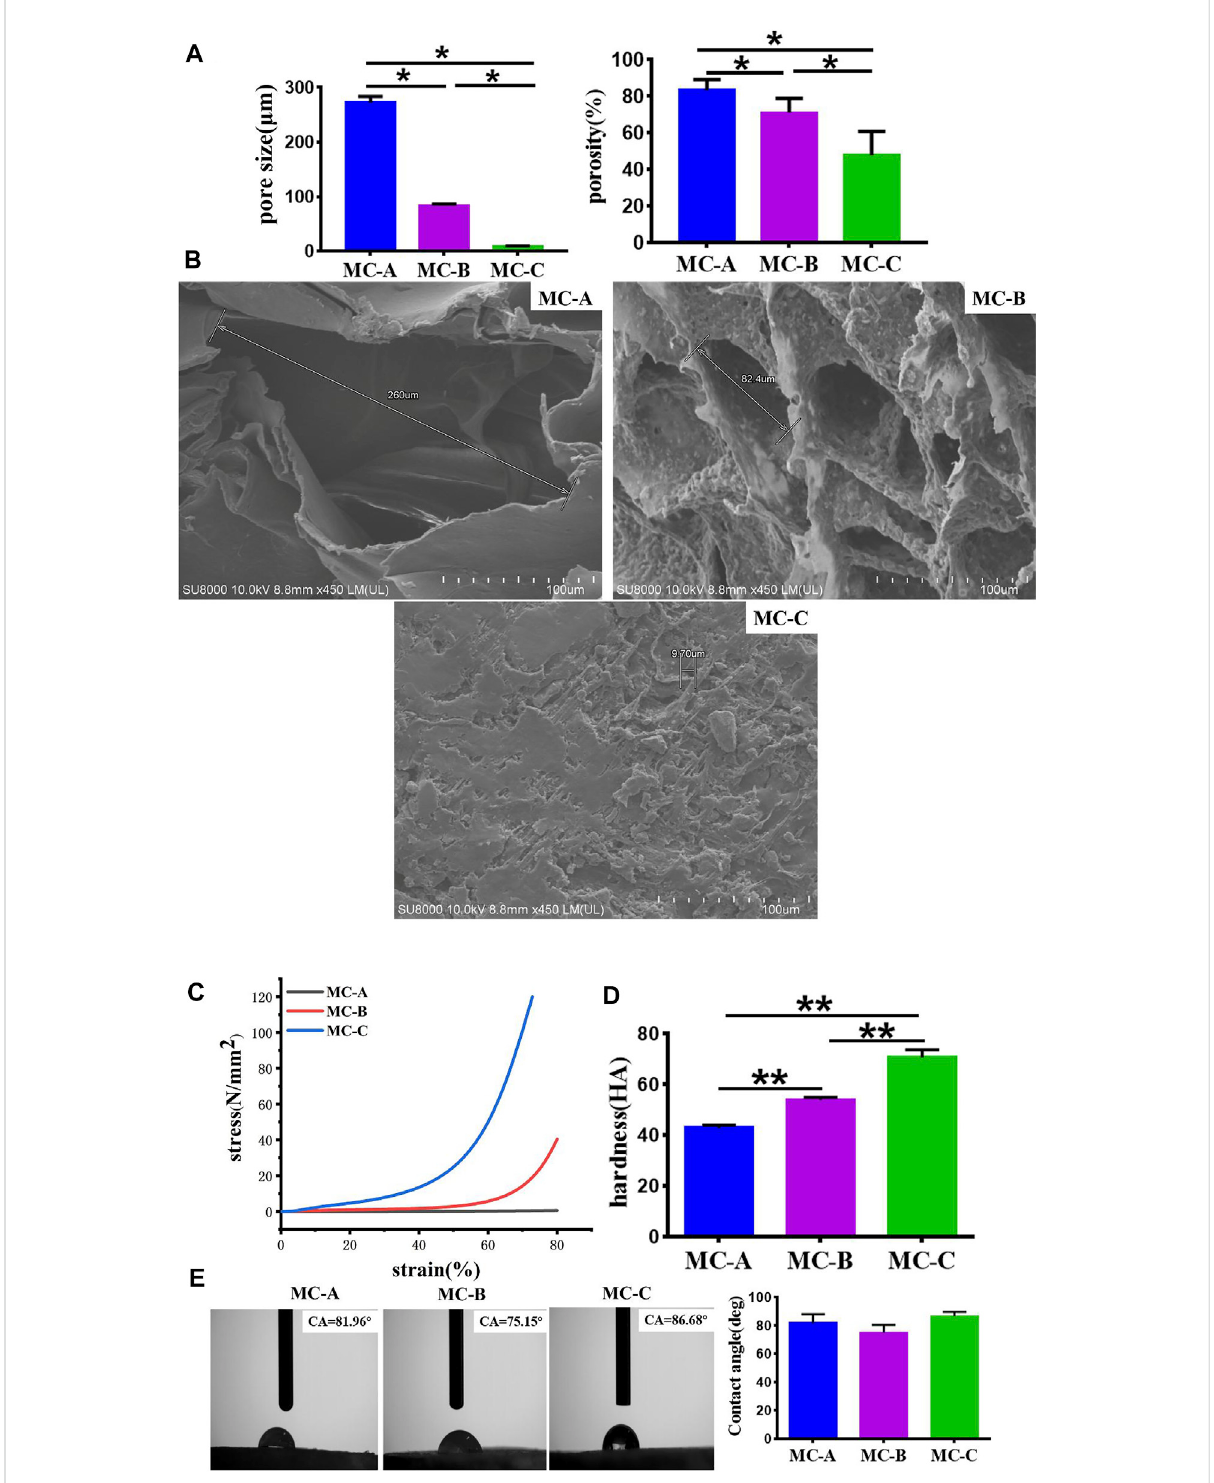
FIGURE 2 Characterizations of mineralized collagen. (A) The pore size and porosity of MC-A, MC-B, and MC-C; (B) FESEM micrographs of MC-A, MC-B, and MC-C (scale bar:100 μ m); (C) Compression mechanics of MC-A, MC-B, and MC-C ; (D) Shore hardness of MC-A, MC-B and MC-C ; (E) Water contact angle of MC-A, MC-B, and MC-C . Data are presented as mean ± SD. *p < 0.05 ; **p < 0.01